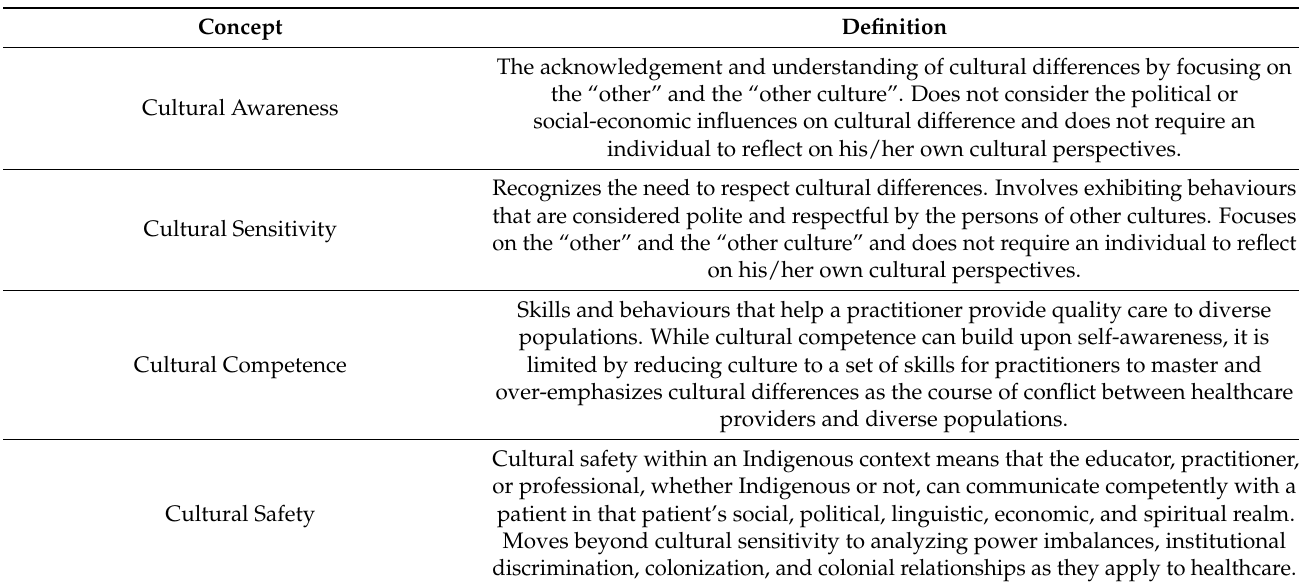
Table 3. Defining Cultural Safety, Cultural Competence, and Similar Concepts (Baba 2013)